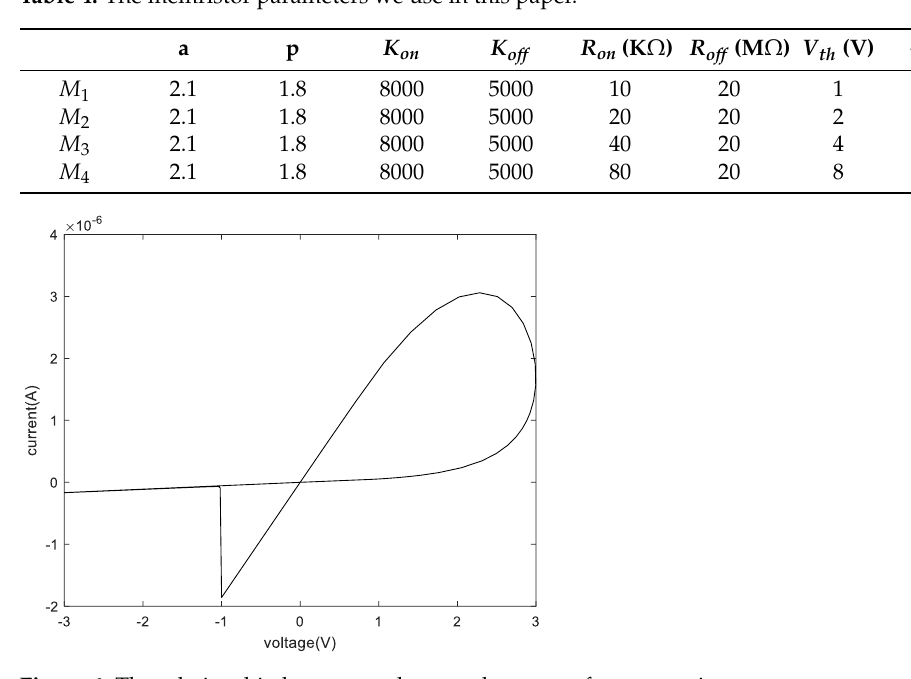
Figure 6. The relationship between voltage and current of one memristor.